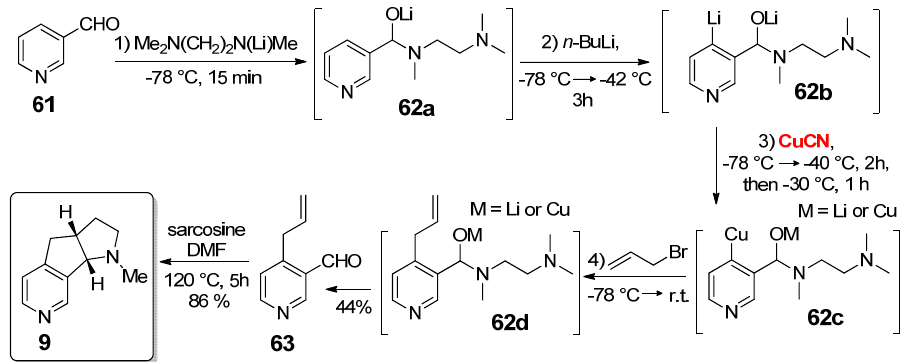
Scheme 8. Synthesis of conformationally restricted nicotine analogue 9 developed in 2004 by Zhai et